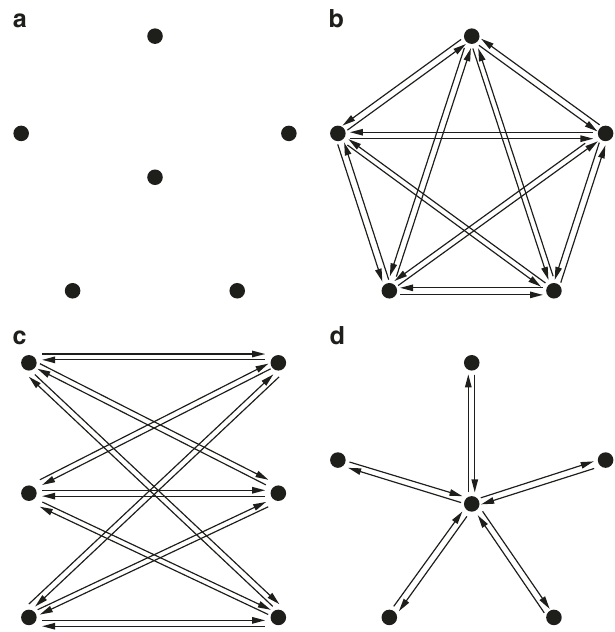
Fig. 3 Sketch of the prototypical network motifs studied here. a Empty, b Complete, c Balanced Complete Bipartite, and d Star Network. All links shown have unitary